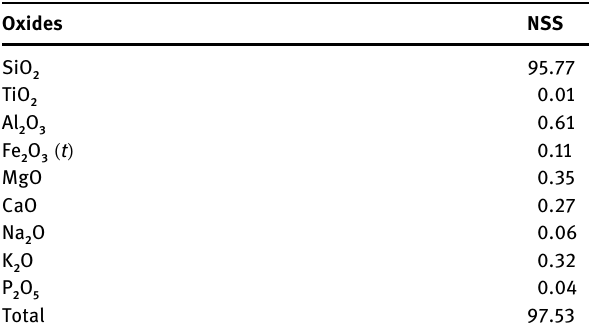
Table 2: SSHWC mixing ratios/1 m 3